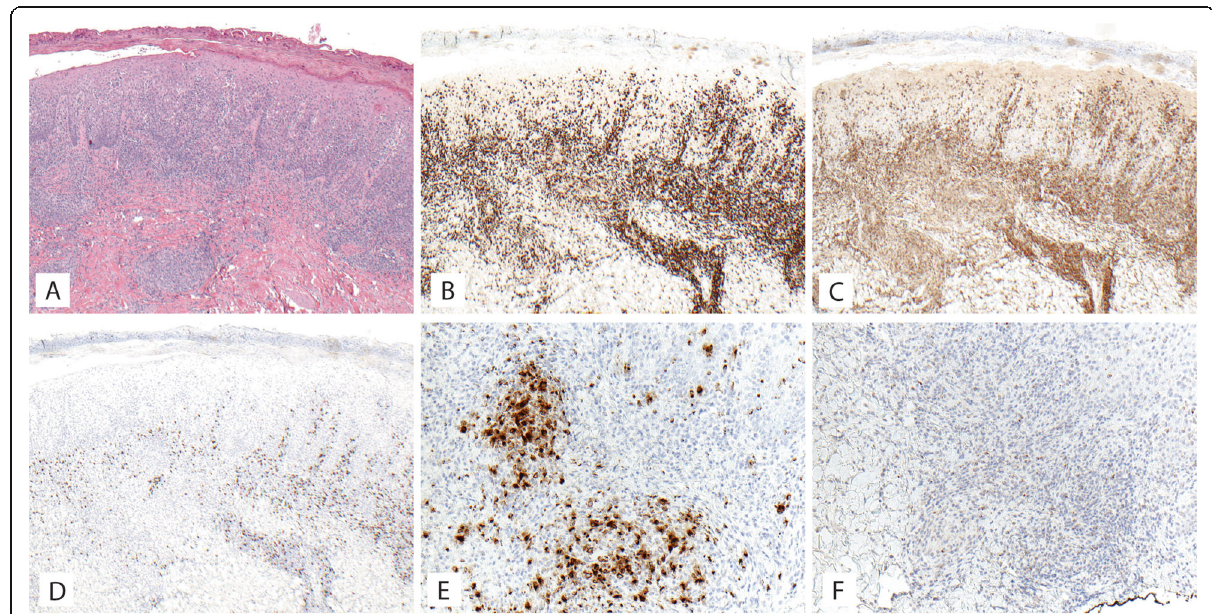
Fig. 3 Microscopic images of Case 1 biopsy of left thigh lesion. a , Lichenoid and epidermal infiltrate; H&E 40X. b CD3 immunostain; 40X. c CD4 immunostain; 40X. d CD8 immunostain; 40X. e granzyme immunostain; 40X. f TIA1 immunostain;